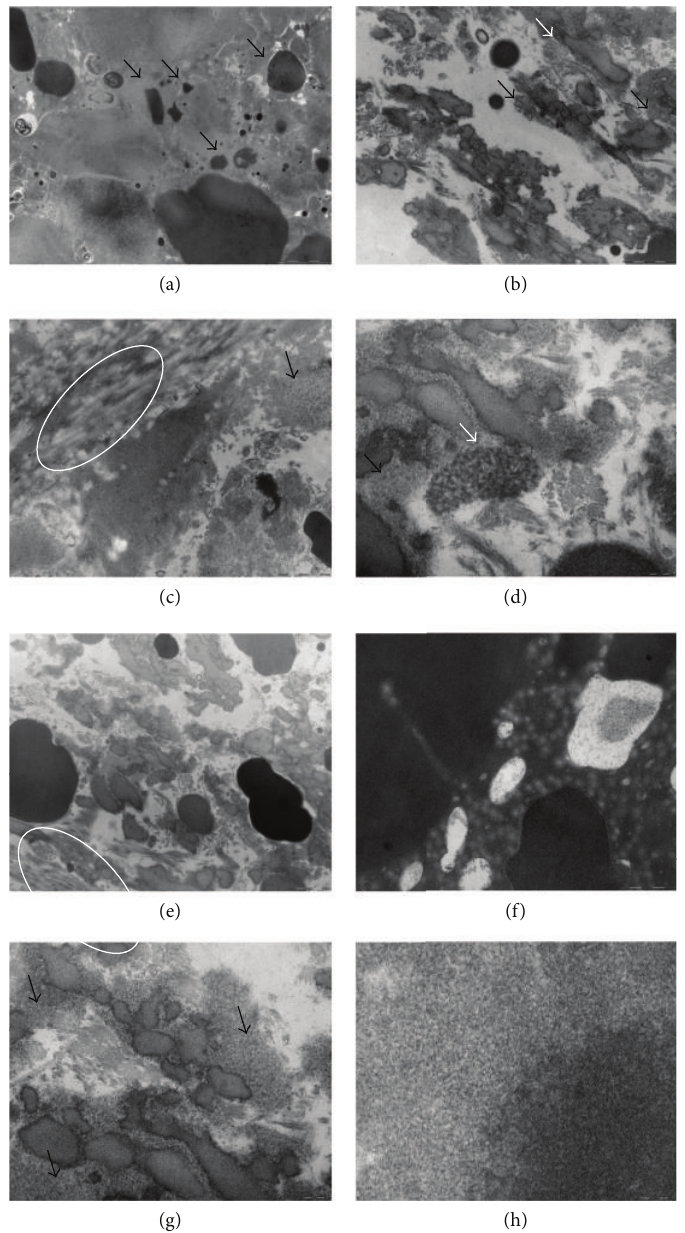
Figure 3: TEM observation of AKU aortic valve . (a) Large deposits of extracellular ochronotic pigment associated with areas of valvular calcification (arrows). Bar 2 𝜇 m. (b) Pathological alterations and calcification (white arrow) involving surface endothelium with cells disgregation and sprinkled Golgi complex and ER (black arrows). Bar 1 𝜇 m. (c) Interweaving networks of collagen fiber bundles (white circle) and aggregates of extracellular ochronotic pigment appeared to be in locations of necrotic cells (black arrow). Bar 1 𝜇 m. (d) Intracellular ochronotic pigment (black arrow) and an example of apoptotic cell with condensed chromatin and disrupted mitochondrion (white arrow). Bar 200 nm. (e), (f), and (g) ECM organization is disrupted and ECM trilaminar stratification is lost as evidenced by disorganized and fragmented collagens and elastin fibres strictly interconnected to pigment “squirts” (white circle and arrows); in (f) a necrotic cell is shown with multiple dysmorphic mitochondria. (e) Bar 1 𝜇 m; (f) bar 500 nm; (g) bar 200 nm; (h) bundles of amyloid fibrils nearby ochronotic deposits. Bar